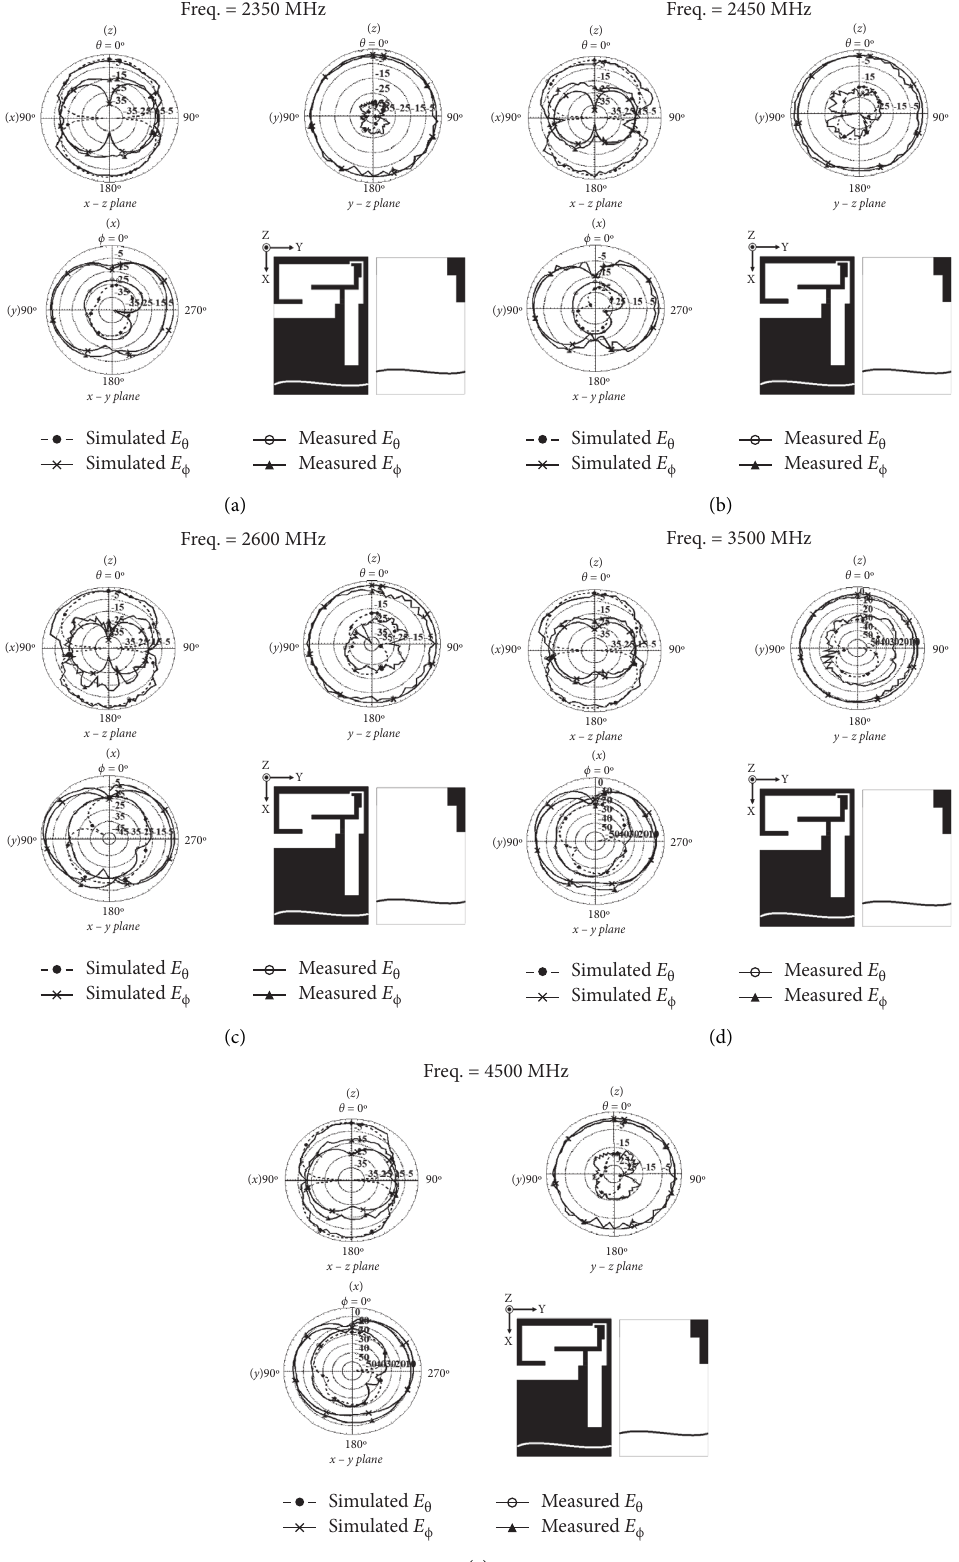
Figure 5: The simulation and measurement antenna radiation patterns under different operating frequency conditions: (a) 2350MHz; (b) 2450MHz; (c) 2600MHz; (d) 3500MHz; (e)